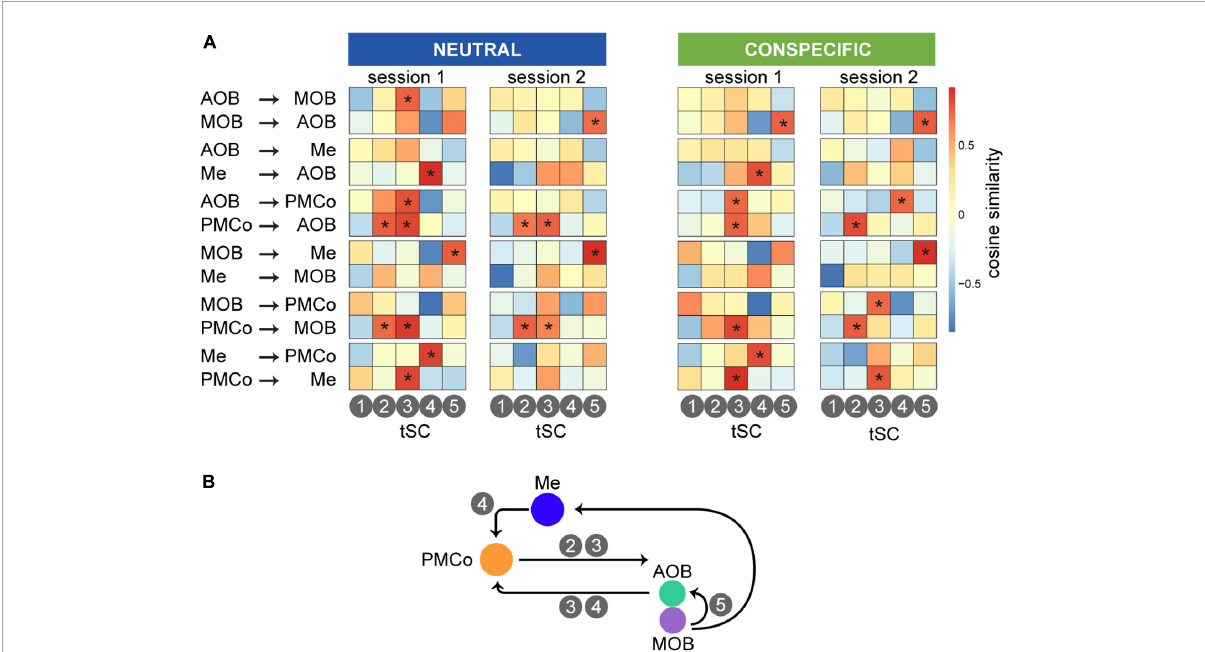
FIGURE8 Causality-theta nested correlation for the set of grouped stimuli. (A) Similarity matrices ordered by causal interactions between areas (horizontal axis) and tSCs (vertical axis). In a color range between warms (reds, high similarity) and colds (blue, low similarity), we can observe how different theta components have a presence in the different causal directionality based on the similarity of both spectral profiles. Asterisks represent significance when the similarity values are above a threshold, defined as the 0.9 quantile of the normal distribution of the measures. (B) Schematic summary of the representative participation of the tSCs in the causal